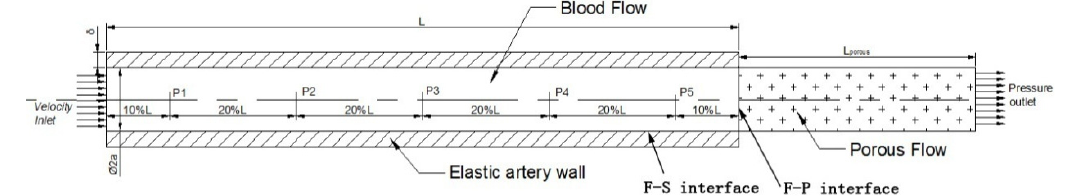
Figure 1. Calculation model and schematic of measuring point distribution.